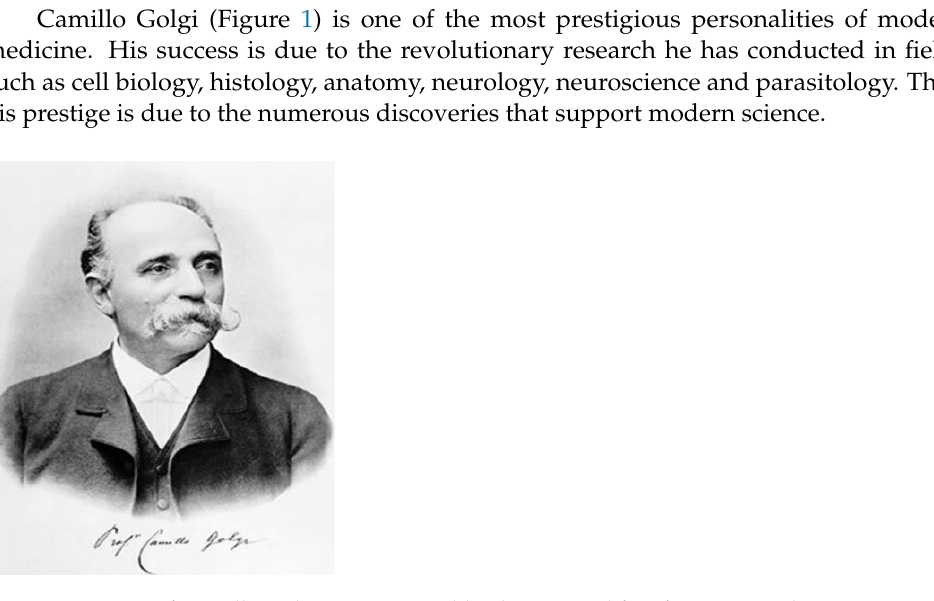
Figure 1. Picture of Camillo Golgi. Image in public domain and free from copyright issues.